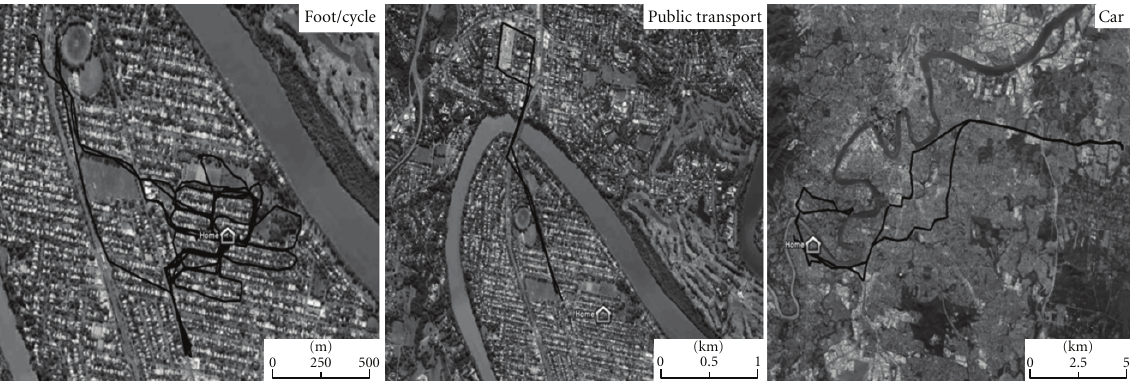
Figure 2: Maps showing use of transportation by one